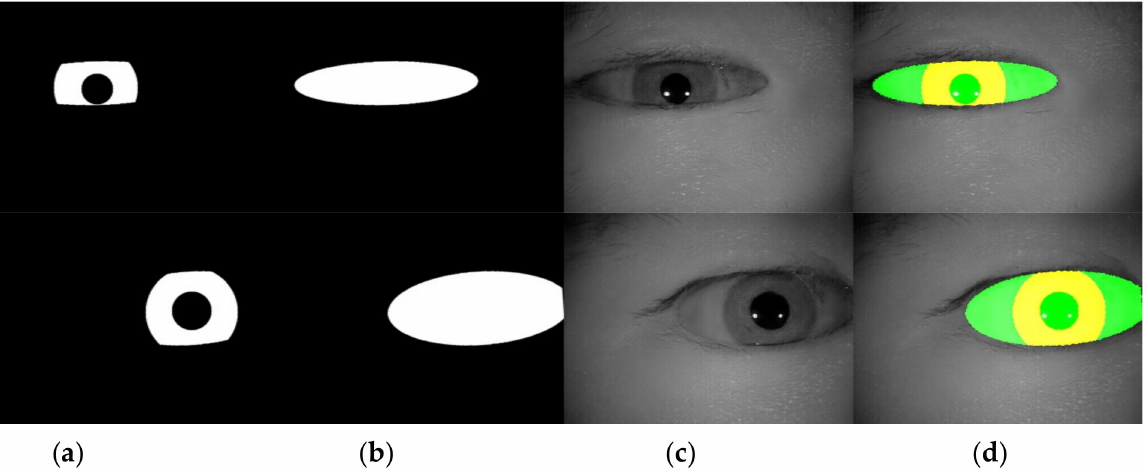
Figure 7. A pictorial example of generated masks for iris images. ( a ) The generated iris mask; ( b ) the generated periocular mask; ( c ) the generated iris image; ( d ) the overlay of iris mask, periocular mask and the generated image. It shows that the generated masks perfectly fit the iris